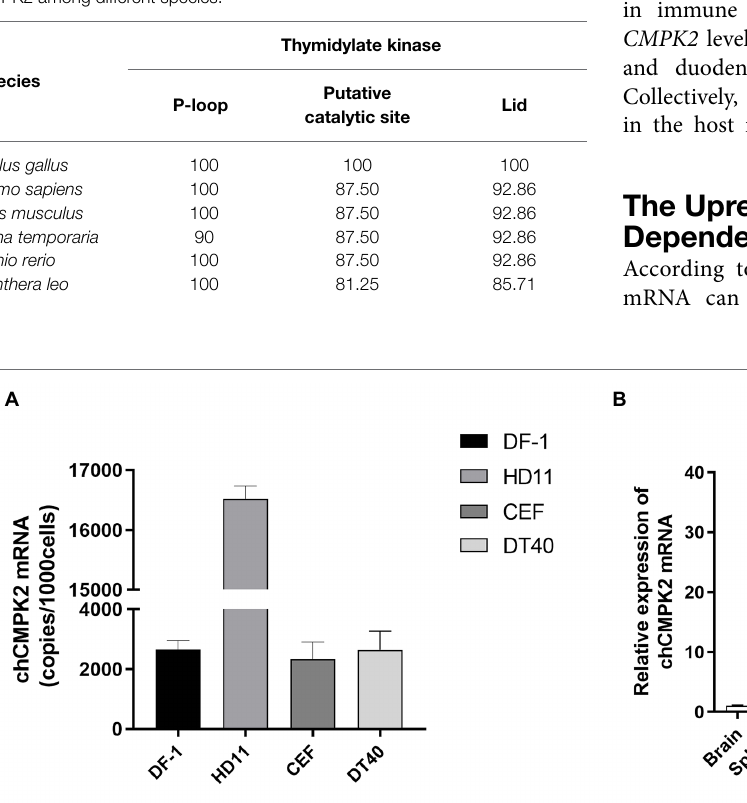
TABLE 3 | P-loop, catalytic site, and lid motif amino acid sequence similarity of CMPK2 among different species.